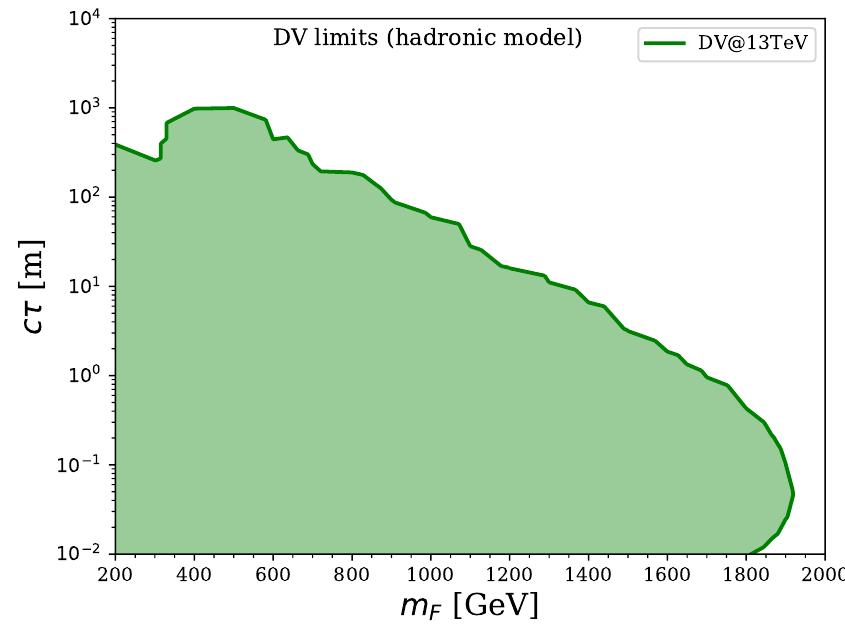
Figure 6 . Region in the c(cid:28) vs m F plane excluded at 95% C.L. by the ATLAS 13 TeV displaced vertex plus MET search